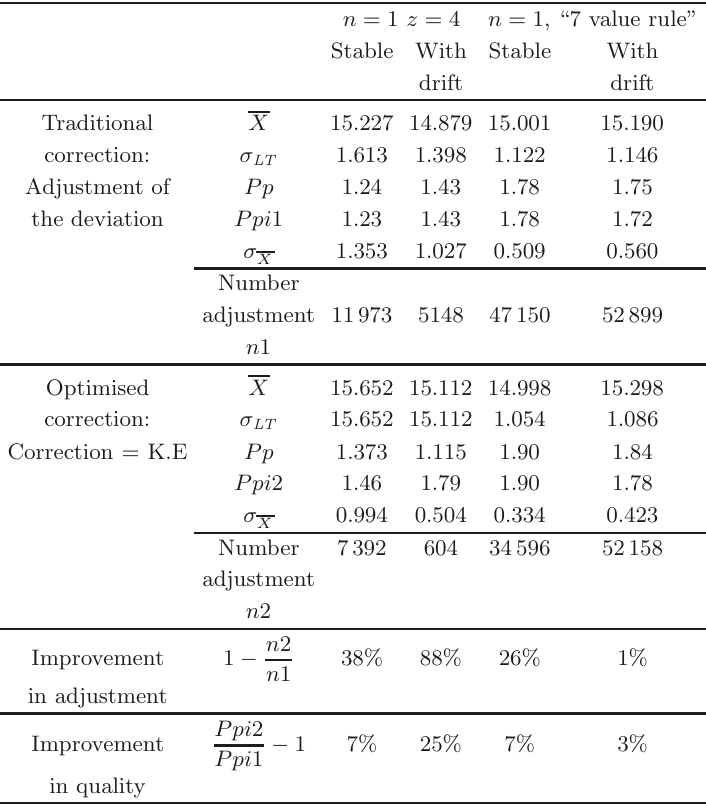
Table 8. Simulation with z = 4 and the “7 values rule”.